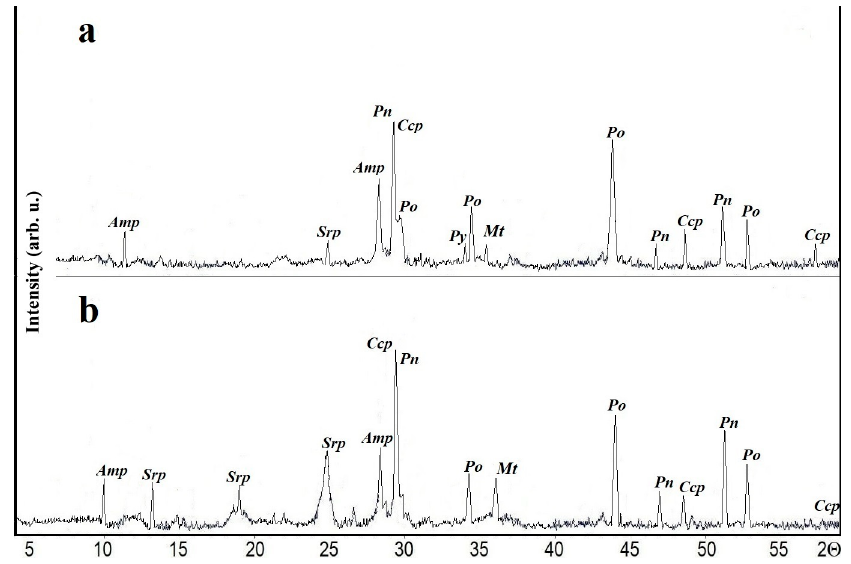
Figure 2. X-ray diffraction pattern of the Allarechensk TD samples: ( a ) feed ore; ( b ) ore after leaching. Amp: amphibole; Srp: serpentine; Po: pyrrhotite; Pn: pentlandite; Ccp: chalcopyrite; Mt: magnetite.